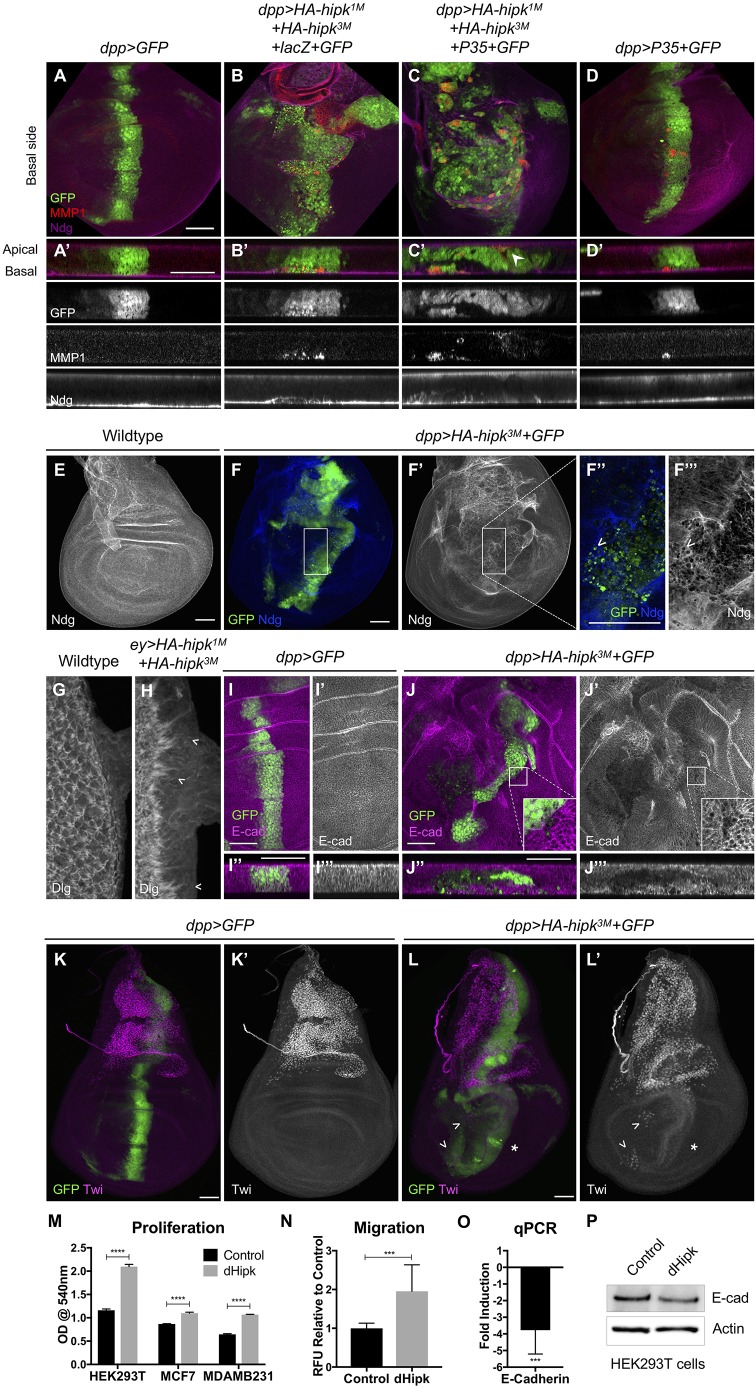
Hipk alters epithelial integrity and induces EMT. (A,A′) A control wing disc (A) and a cross-section of the central region of the disc (A′) stained for GFP, Mmp1 and Ndg. (B,B′) dpp>HA-hipk1M+HA-hipk3M+LacZ+GFP stained to detect GFP, Mmp1 and Ndg. (C,C′) dpp>HA-hipk1M+HA-hipk3M+P35+GFP stained to detect GFP, Mmp1 and Ndg. (D,D′) dpp>P35+GFP stained to detect GFP, MMP1 and Ndg. (E) Ndg is expressed in a uniform pattern along the basement membrane. (F-F‴) Gaps in Ndg expression are present in dpp>HA-hipk3M+GFP discs (F′), and higher resolution (F″,F‴) shows that the location of HA-hipk3M+GFP-expressing cells coincides with regions where Ndg is perturbed (arrowheads). (G) Wild-type eye disc stained for Dlg to reveal cell membranes. (H) ey>HA-hipk1M+HA-hipk3M eye disc stained for Dlg showing defects in Dlg stain and apparent cell extensions towards posterior margin of disc (chevrons). (I,J) Cross-sections of dpp>GFP (I) and dpp>HA-hipk3M+GFP-expressing cells (J) in the center of the wing pouch, stained for E-cad. (K) Twi is expressed in the adepithelial myoblasts, located in the notum region of the wing disc. (L) Twi-positive mesenchymal cells are present in the wing pouch region of dpp>HA-hipk3M+GFP discs (arrowheads), and Twi is induced in a swathe of cells along the dpp domain (asterisk). Scale bars: 50 μm. (M) Drosophila Hipk (dHipk) promotes significant proliferation of three cell lines. dHipk-transfected HEK293T cells (mean=2.097, s.e.m.=0.02803) display increased proliferation compared with empty vector transfected (mean=1.161, s.e.m.=0.01619) conditions; t(4)=28.92, ****P<0.0001. dHipk-transfected breast adenocarcinoma MCF7 cells (mean=1.098, s.e.m.=0.01217) display increased proliferation compared with empty vector transfected (mean=0.8671, s.e.m.=0.0035) conditions; t(4)=18.25, ****P<0.0001. dHipk-transfected breast adenocarcinoma MDA-MB-231 cells (mean=1.067, s.e.m.=0.0037) display increased proliferation compared with empty vector transfected (mean=0.6457, s.e.m.=0.0074) conditions; t(4)=50.83, ****P<0.0001. (N) dHipk-transfected MDA-MB-231 cells (mean=1.953, s.e.m.=0.2277) demonstrated significantly increased migration compared with empty vector transfected (mean=0.9999, s.e.m.=0.0375) conditions; t(19)=4.759, ***P=0.0001. (O) qRT-PCR was used to quantify the expression of the human E-cadherin gene (CDH1) after transfection of MDA-MB-231 cells with dHipk [t(2)=34.86, ***P=0.0008]. (P) Western blot analysis of E-cad expression in HEK293T cells after dHipk transfection.